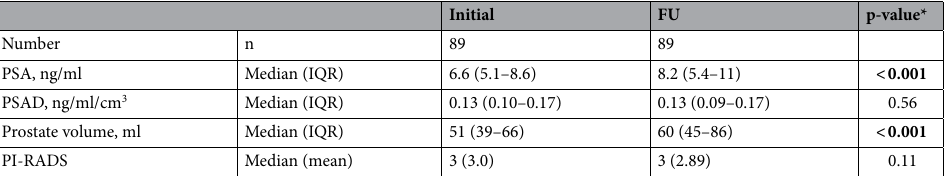
Table 1. Baseline characteristics initially and during follow up. FU: follow up; PSA: prostate specific antigen; PSAD: prostate specific antigen density; PI-RADS: Prostate Imaging Reporting and Data System; IQR: interquartile range. *Wilcoxon signed rank test. Significant values are given in